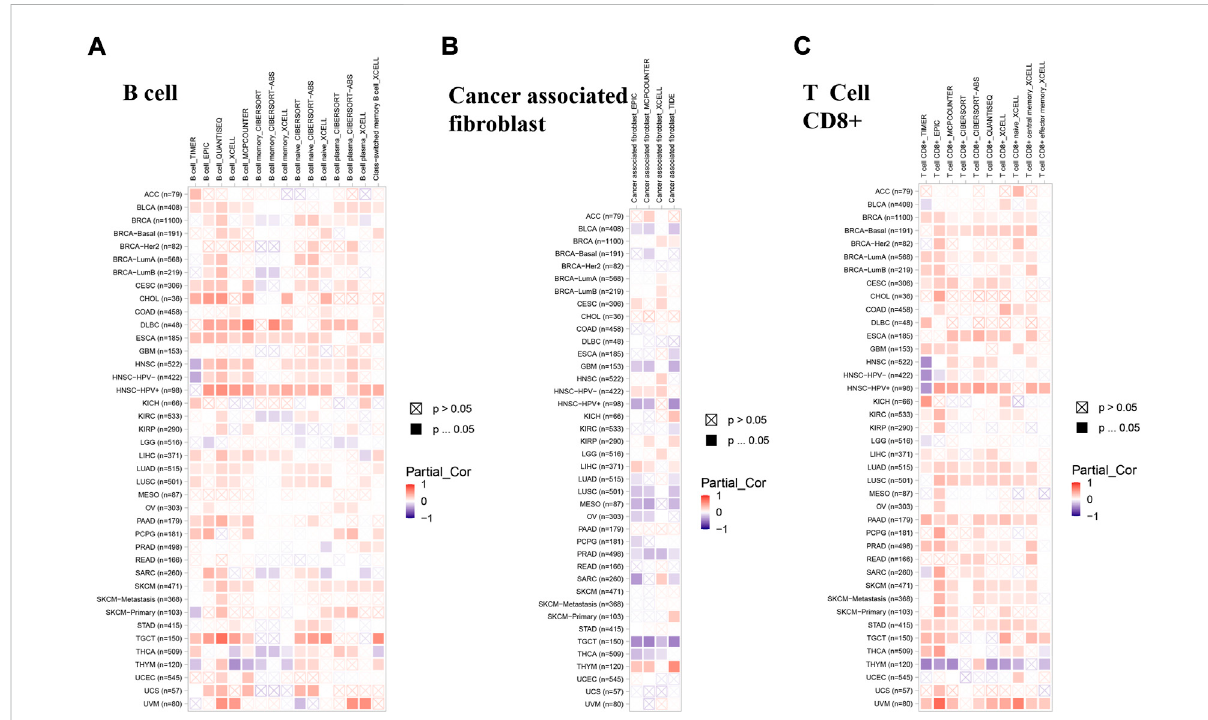
FIGURE 6 The correlation between immune cells and LIPT1 expression in cancers. (A – C) The relationship between LIPT1 expression and immune in fi ltration of B cell (A) , cancer-associated fi broblast (B) and T cell CD8 + (C) was depicted by TIMER2.0 database. Several algorithms, such as TIMER, EPIC, QUANTISEQ, XCELL, MCPCOUNTER, CIBERSORT, CIBERSORT-ABS, and TIDE, were applied to explore the correlation. Positive correlation (0 – 1) are indicated with the red color, while negative correlation ( − 1 to 0) are indicated with the blue color. p -value < 0.05 is considered as statistically signi fi cant. A cross indicates non-signi fi cant